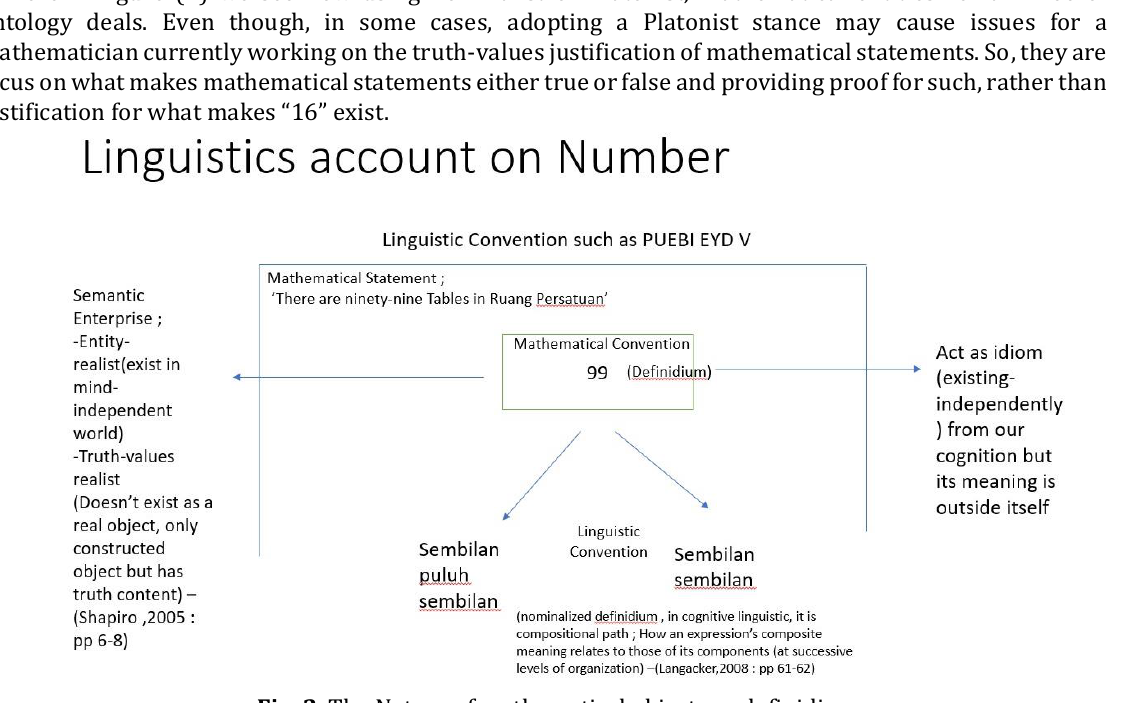
Fig. 2. The Nature of mathematical objects as